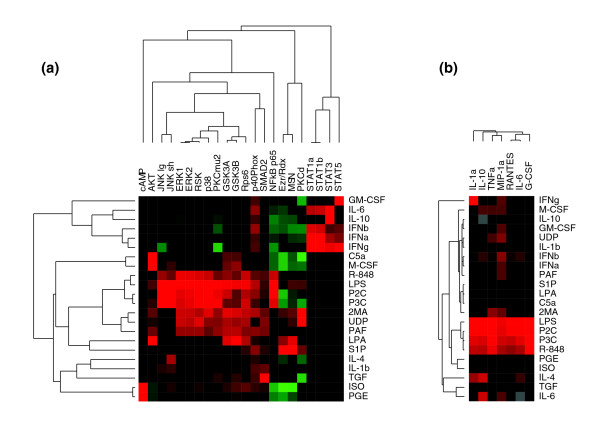
Two-way hierarchical clustering of the RAW 264.7 macrophage. (a) Signaling pathway responses and (b) cytokine release after single ligand stimulations. Average linkage clustering was performed using un-centered Pearson's correlation metrics on log-transformed and variance-normalized data. Data are averages over the different time points and across repeated experiments. Red = positive change; green = negative change.